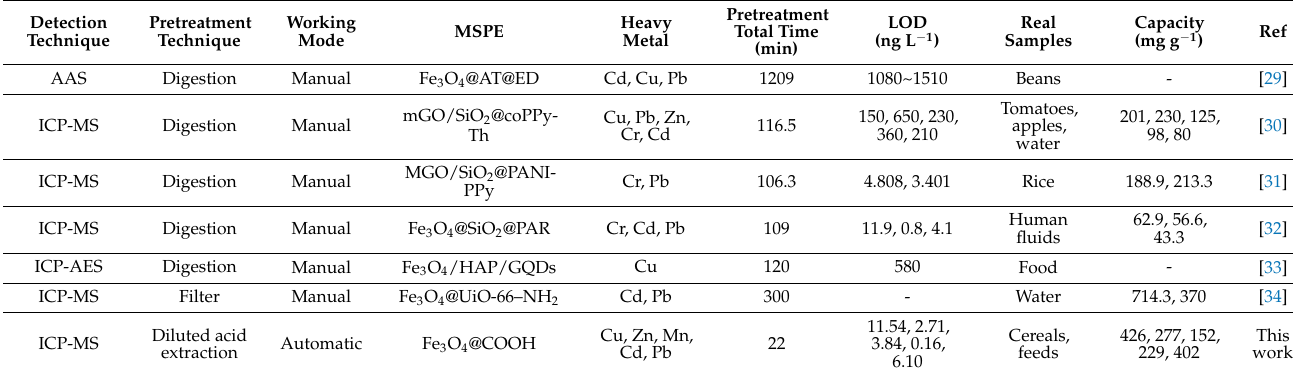
Table 3. Comparison of the proposed method with reported